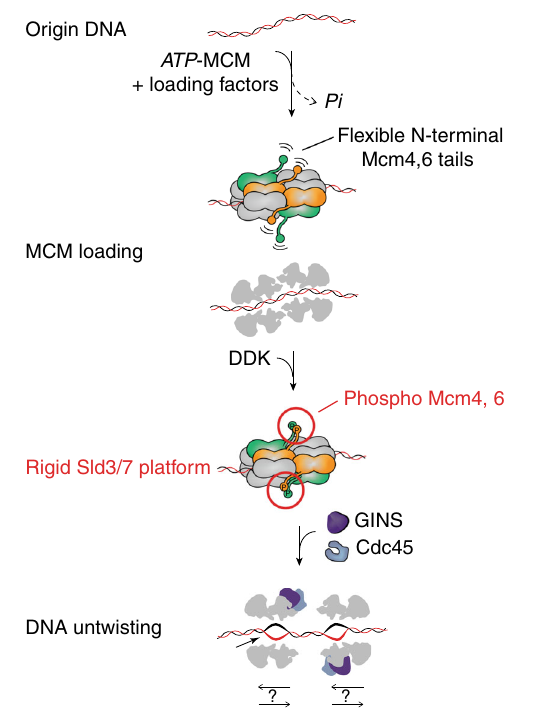
Fig. 6 Model for replication initiation. MCM is loaded onto origin DNA in a process that requires ATP hydrolysis by MCM. In the loaded double hexamer, duplex DNA runs through the entire length of the central